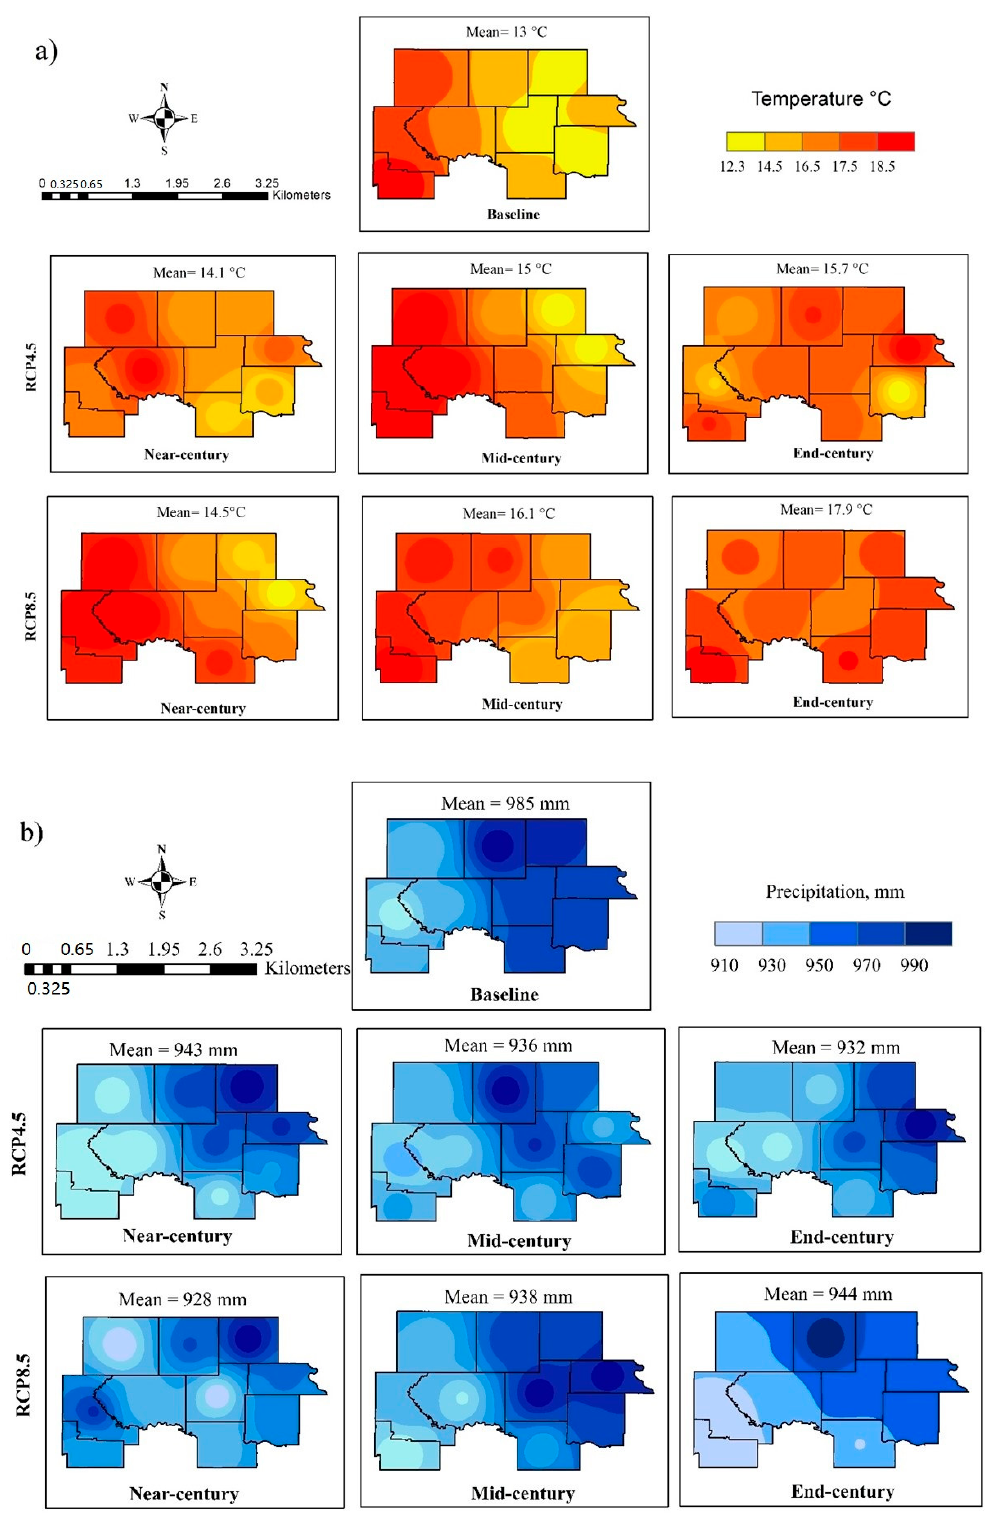
Figure 7. Spatial distribution of ( a ) annual mean temperature ( ◦ C) and ( b ) precipitation (mm) obtained from the ensemble mean of 18 GCMs for near-century (2010 − 2039), mid-century (2040 − 2069), and end-century (2070 − 2099) under RCP 4.5 and RCP 8.5 emission scenarios in comparison to the baseline (1990 − 2019) study period for ten rainfed maize producing counties in northeast